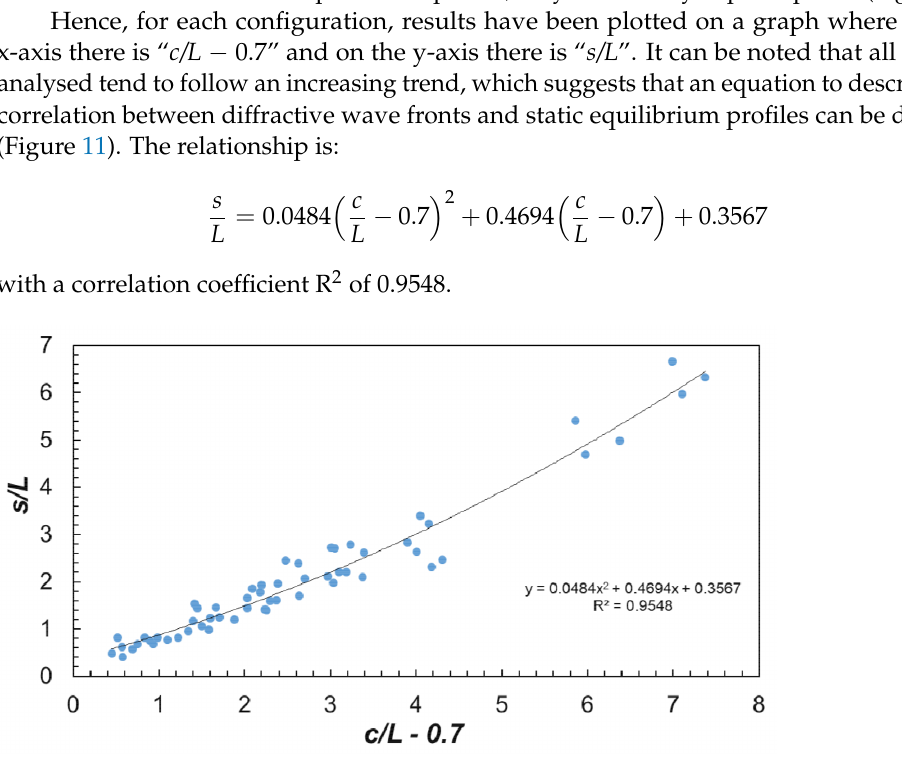
Figure 11. numerical simulations values of s / L in function of c / L , together with the best